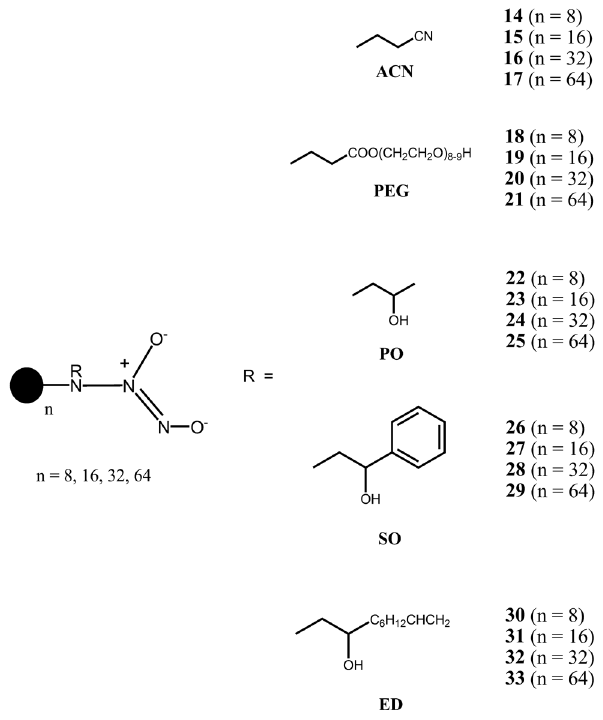
FIGURE 6 - Schematic representation of PPI dendrimer functionalized with different ligands and diazeniumdiolates (adapted from Lu et al. , 2011; Sun, et al. , 2012).